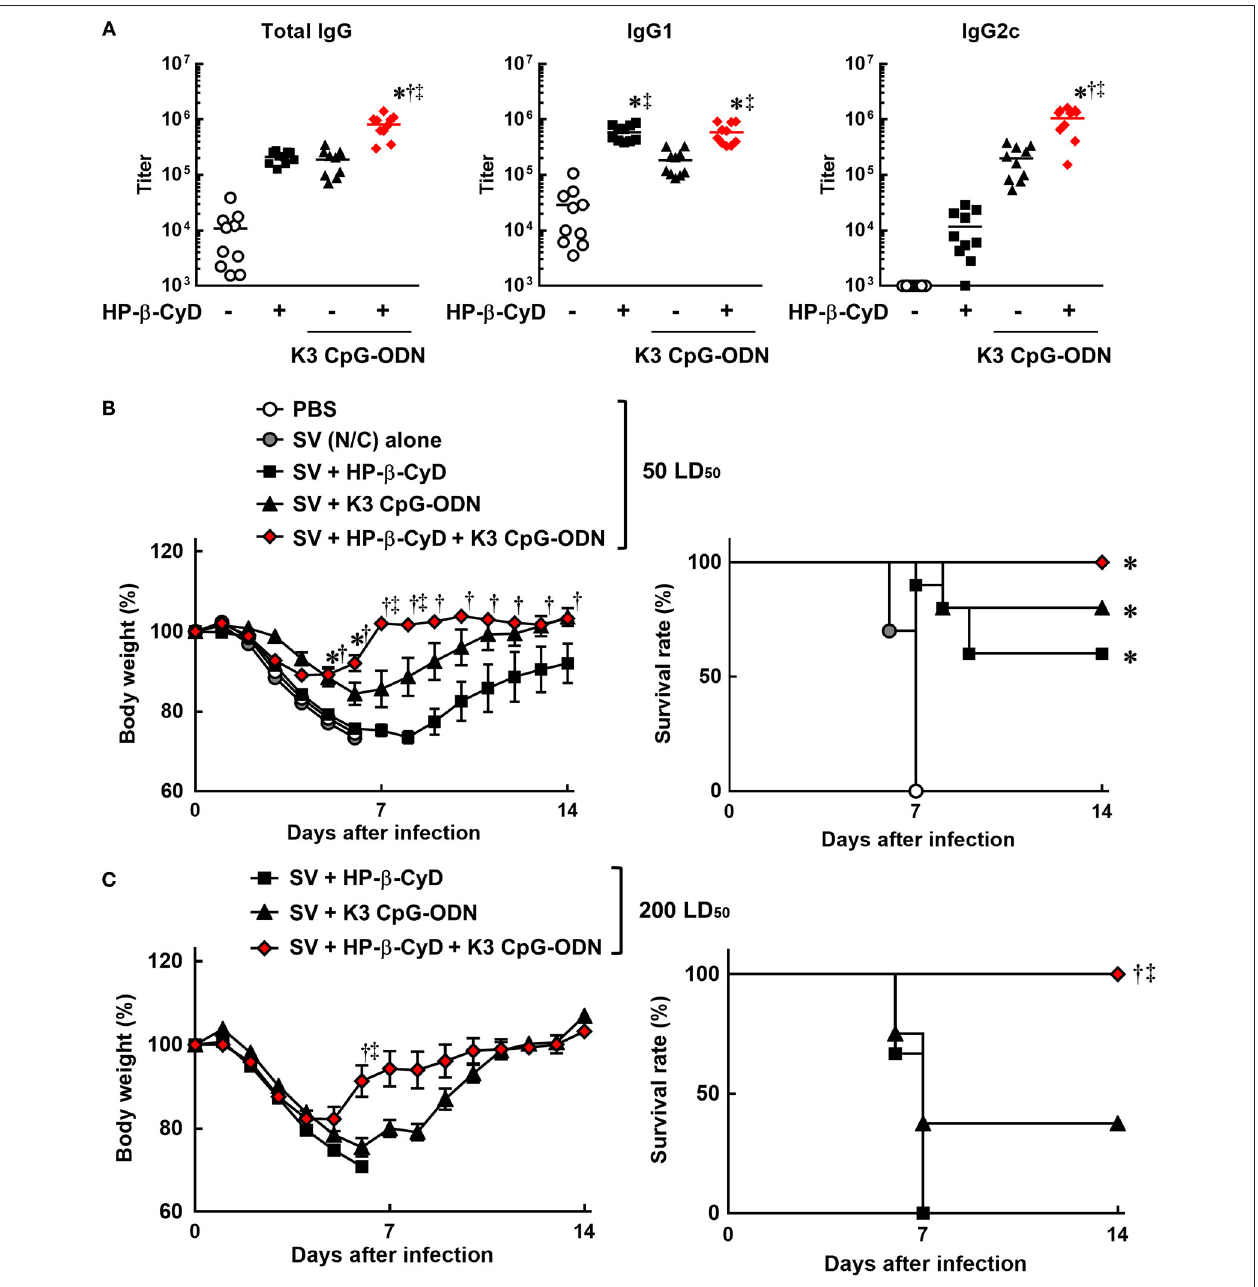
FIGURE 2 | HP- β -CyD and K3 CpG-ODN cooperatively improve the efficacy of influenza split vaccine (SV) against influenza viral infection in mice. (A–C) C57BL/6 mice were inoculated with 3 µ g of SV (New Caledonia strain) containing 30% HP- β -CyD and 10 µ g of CpG-ODN into the base of the tail on day 0 and 14. (A) Blood was collected 7 days after boost and anti-HA total IgG, IgG1, and IgG2c were determined by ELISA. Each dot represents an individual mouse ( n = 10 per group, representative data of 2 independent experiments). * p < 0.05 compared with SV alone, † p < 0.05 compared with SV + HP- β -CyD, ‡ p < 0.05 compared with SV + K3 CpG-ODN (one-way ANOVA with Bonferroni’s multiple comparison test). (B,C) Seven days after the last immunization, mice were challenged with 50 (B) or 200 (C) LD 50 of influenza virus A/PR/8(H1N1) by intranasal administration and body weight and survival rate were monitored. Each point represents the mean ± S.E. ( B ; n = 4–10, C ; n = 9 per group, representative data of 2 independent experiments). * p < 0.05 compared with SV alone, † p < 0.05 compared with SV + HP- β -CyD, ‡ p < 0.05 compared with SV + K3 CpG-ODN [one-way ANOVA with Bonferroni’s multiple comparison test for body weights or Kaplan-Meier analysis (log-rank test and Wilcoxon’s test for survival curves comparisons)].